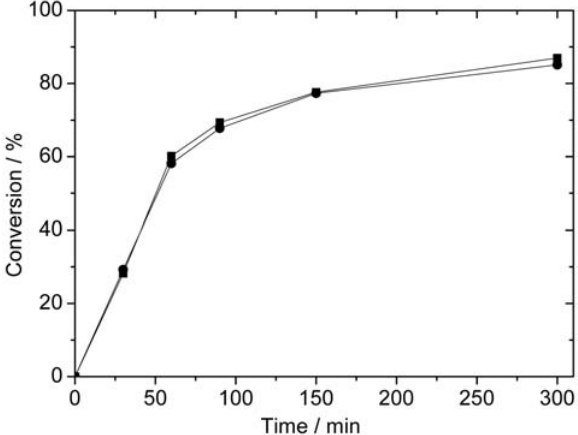
Figure 5. Kinetic monitoring of cis -cyclooctene epoxidation with O in the presence of the molybdenum complexes. (cid:2) re- TBHP–H 2 presents 1 , (cid:3) represents 2 .